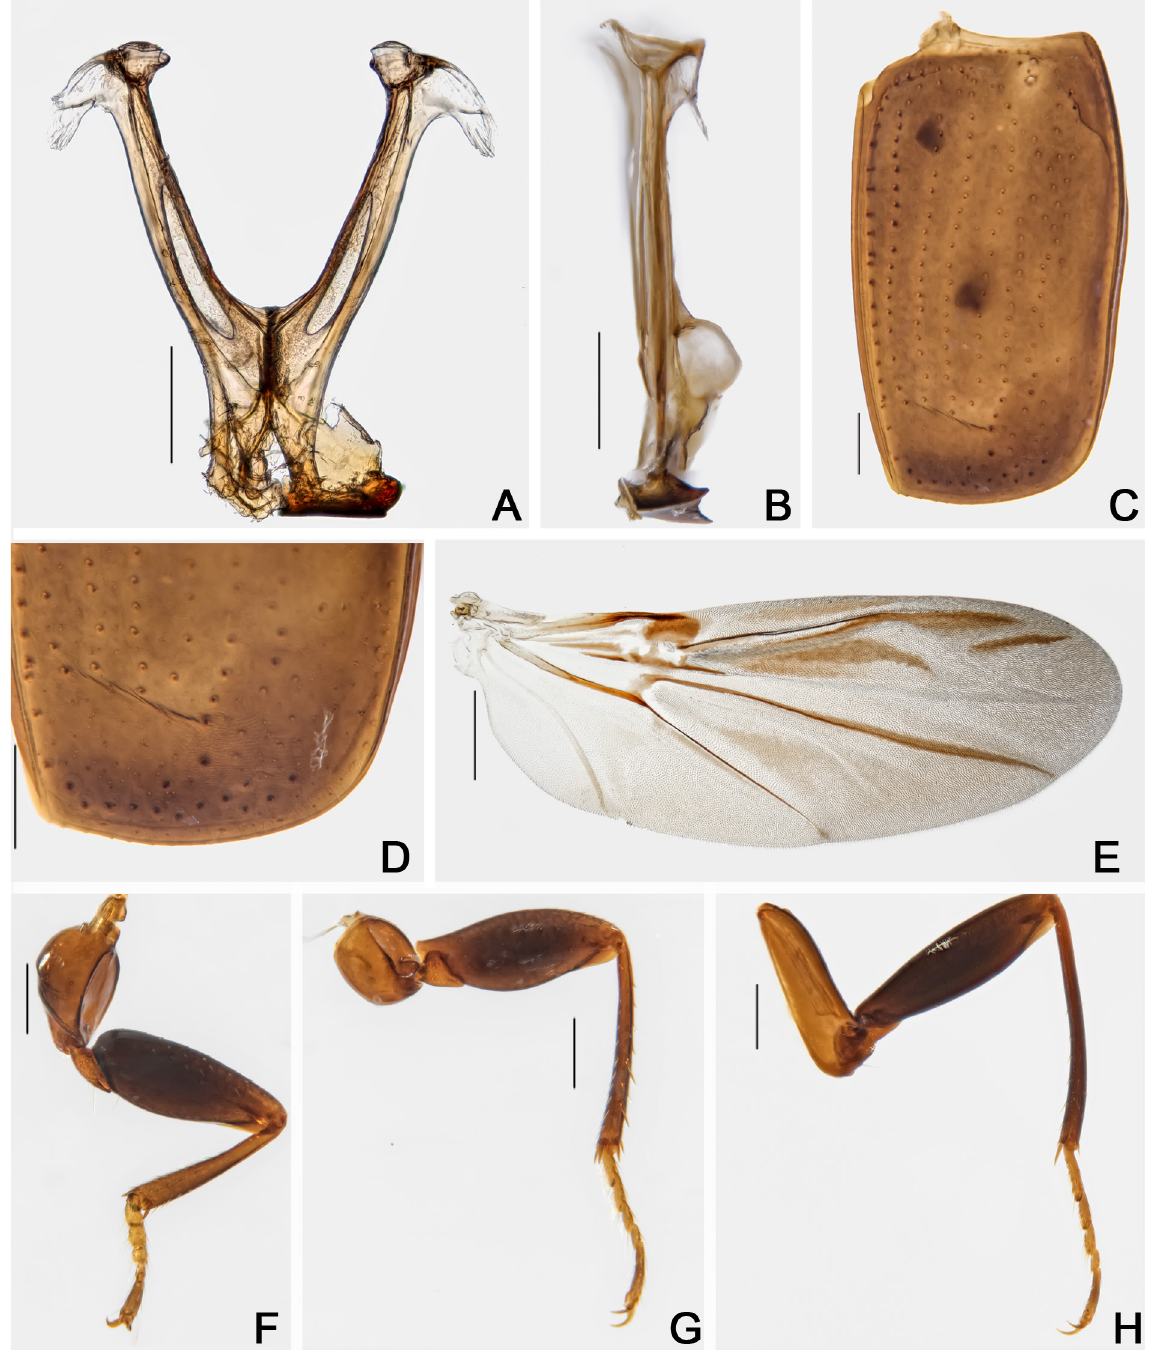
Fig. 34. Cyparium newtoni sp. nov., paratype, ♂ (CELC). A–B . Metendosternite. A . Dorsal view. B . Lateral view. C–D . Elytron. C . Entire. D . Apex. E . Hind wing. F–H . Legs. F . Fore. G . Middle. H . Hind. Specimens collected at Mata da Biologia, Viçosa (MG, Brazil). Scale bars: A–D, F–H = 0.2 mm; E = 0.5